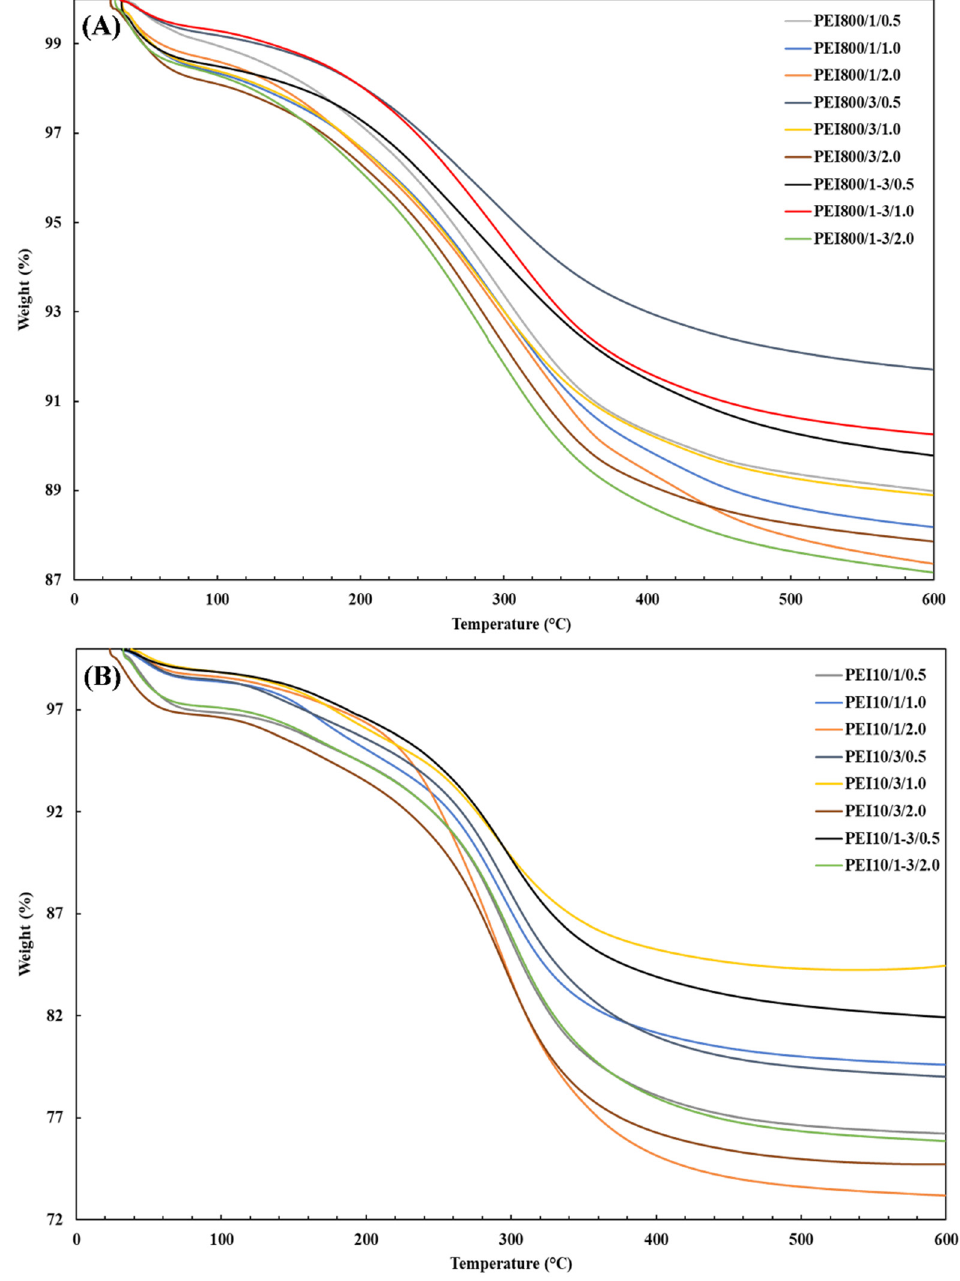
Figure 7. TGA thermograms for the sample series ( A ) PEI800/Y/Z and ( B ) PEI10/Y/Z after extraction .